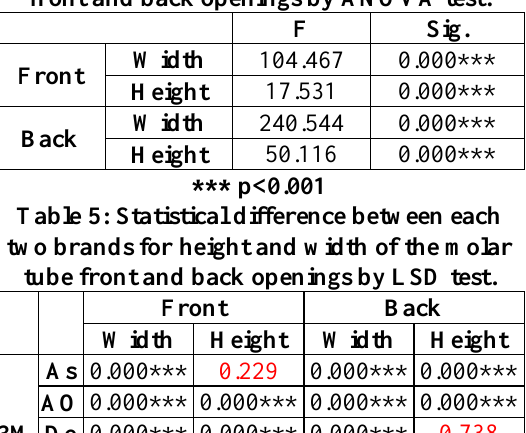
Table 4: Statistical difference between the six brands for height and width of the molar tube front and back openings by ANOVA test.